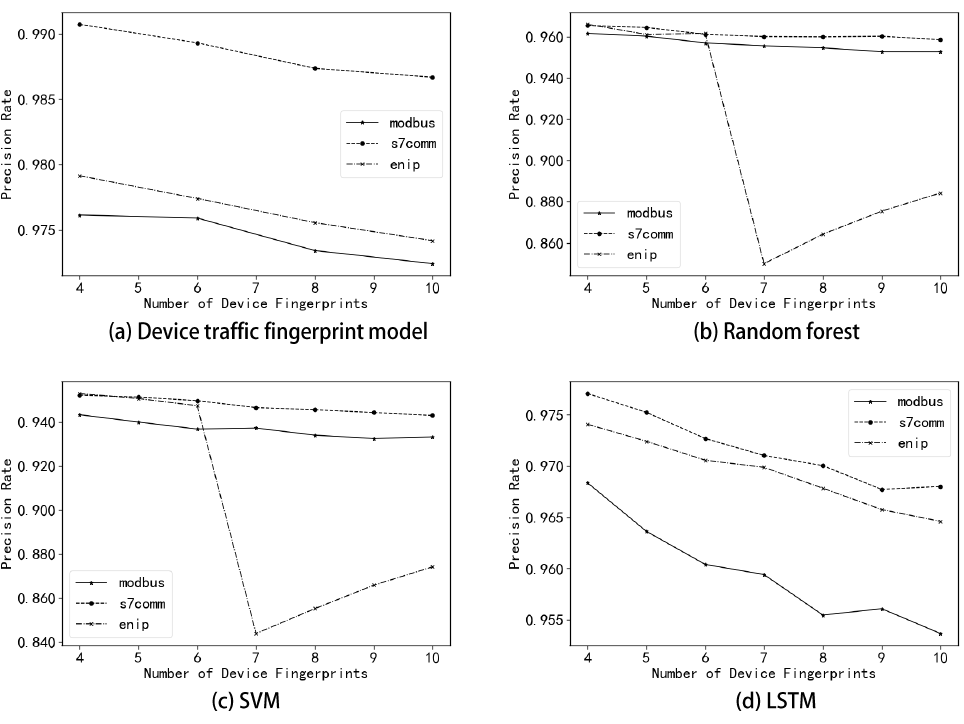
Figure 13. Precision curves of the four